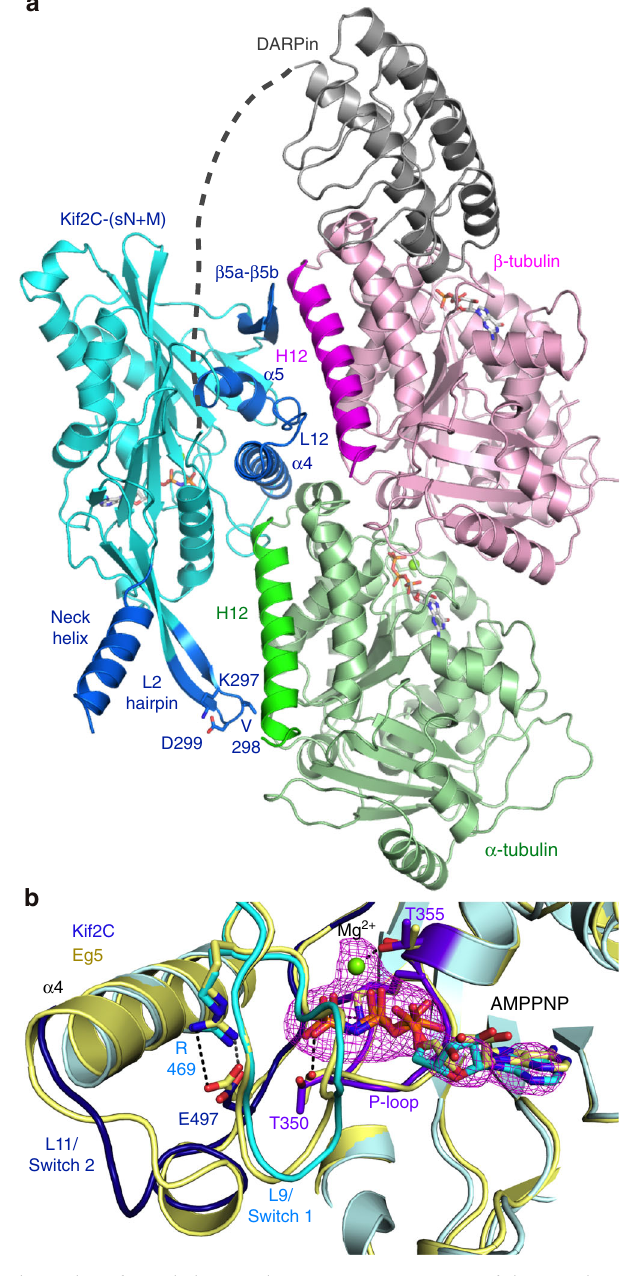
Fig. 2 The Kif2C – tubulin complex structure. a Overview of the complex crystallized. The (G 4 S) 4 -GGS linker between Kif2C and the DARPin was not de fi ned in the electron density maps and is shown as a grey dotted line . See Supplementary Fig. 2 for stereo views of electron density omit maps. b Close-up of the nucleotide binding site of Kif2C and comparison with AMPPNP-Eg5 ( yellow , pdb id 3HQD 26 ). The Kif2C nucleotide is presented with its F obs – F calc electron density omit map contoured at the 3 σ level. The Kif2C phosphate-binding loops (P-loop, Switch 1 and Switch 2) are rendered each in a different shade of blue ( purple blue , cyan and dark blue , respectively). Selected interactions are shown as dotted lines in the Eg5 structure. See Supplementary Fig. 2f for a stereo version of this fi